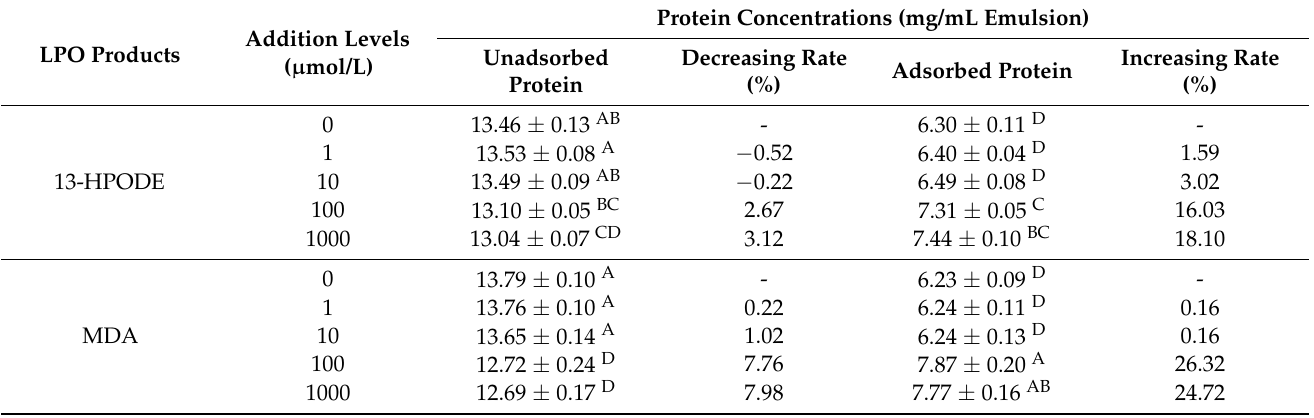
Table 2. Protein concentrations of unadsorbed and adsorbed proteins extracted from the O/W emulsion oxidized by different levels of 13-HPODE or MDA for 48 h.